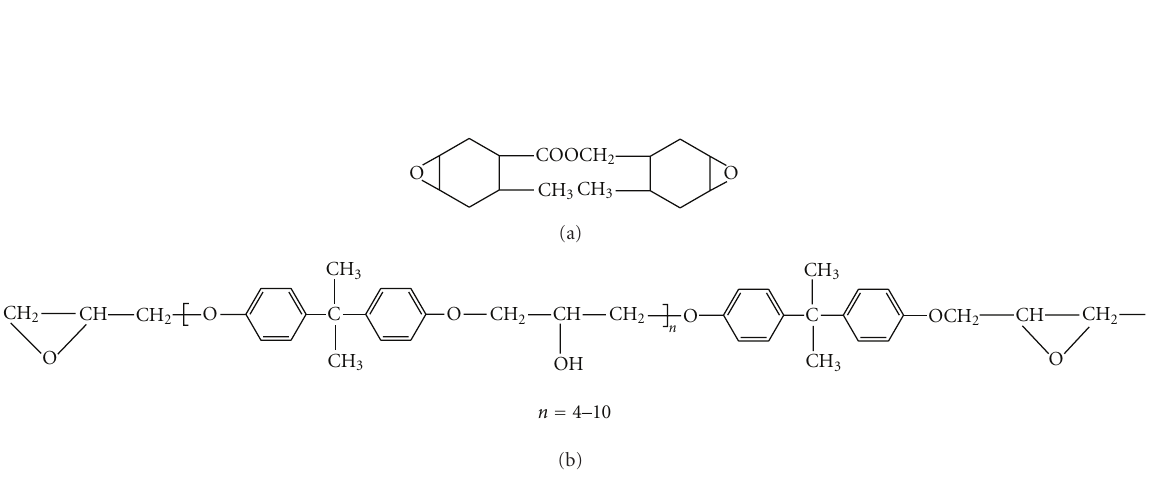
Figure 8: Soliton injection mechanism due to electromechanical compression of the electrode-insulation interface.